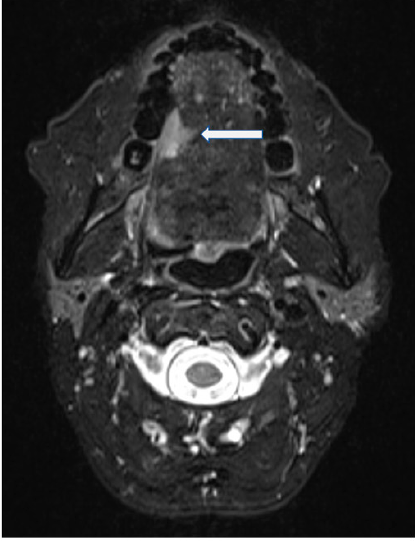
Figure 2. Preoperative image of Case 2 showing squamous cell carcinoma of the right mobile tongue.